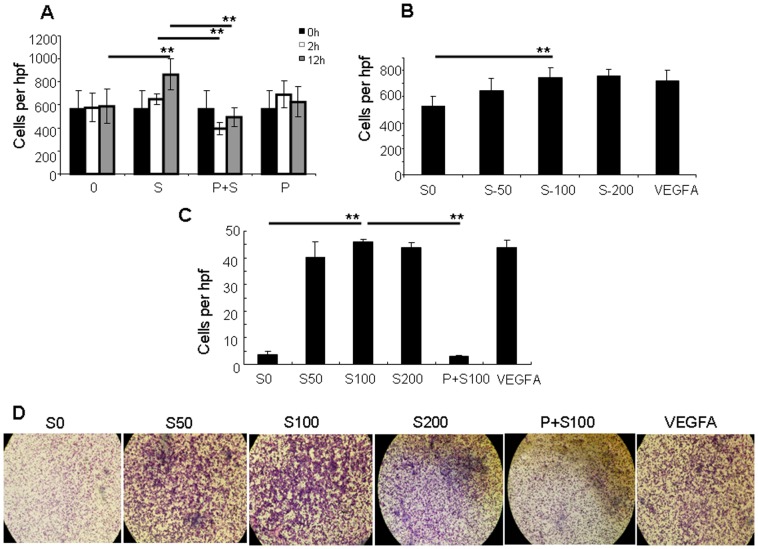
SDF-1α increases adhesion and migration of ECFCs.
A) Increased adhesion of ECFC cells to fibronectin was observed following incubation with SDF-1α for 12 hours (S) compared with controls (0) (** p<0.01). The increase in adhesion due to SDF-1a was completely abrogated at 2 and 12 hours in the presence of plerixafor, a CXCR-4 antagonist (P+S) (** p<0.01). B) Incubating ECFCs with increasing concentrations of SDF-1α (S0  =  0 ng/ml; S50  =  50 ng/ml; S100  =  100 ng/ml; S200  =  200 ng/ml and VEGFA  =  100 ng/ml VEGFA) was associated with increased adhesion to fibronectin. (** p<0.01). C) The migration of ECFCs across a porous membrane was enhanced by the presence of SDF-1 (50 – 200 ng/ml) in the lower part of a Boyden chamber, which was inhibited by plerixafor (P+S100). (** p<0.01) D) The lower side of the porous membrane can be stained to count the number of migrated cells and calculate per membrane pore. (viewed at 40x).